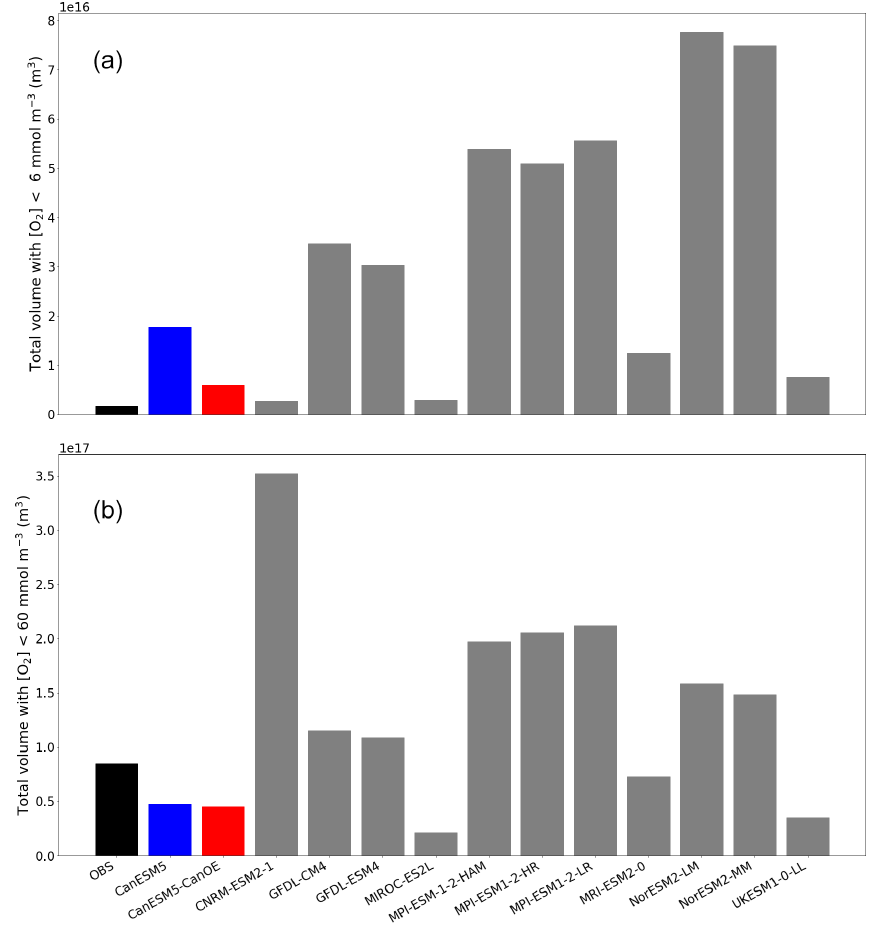
Figure 5. Total volume of ocean with oxygen (O 2 ) concentration less than (a) 6mmolm − 3 (mean for last 30 years of the historical experi- ment) and (b) 60mmolm − 3 . Observation are from